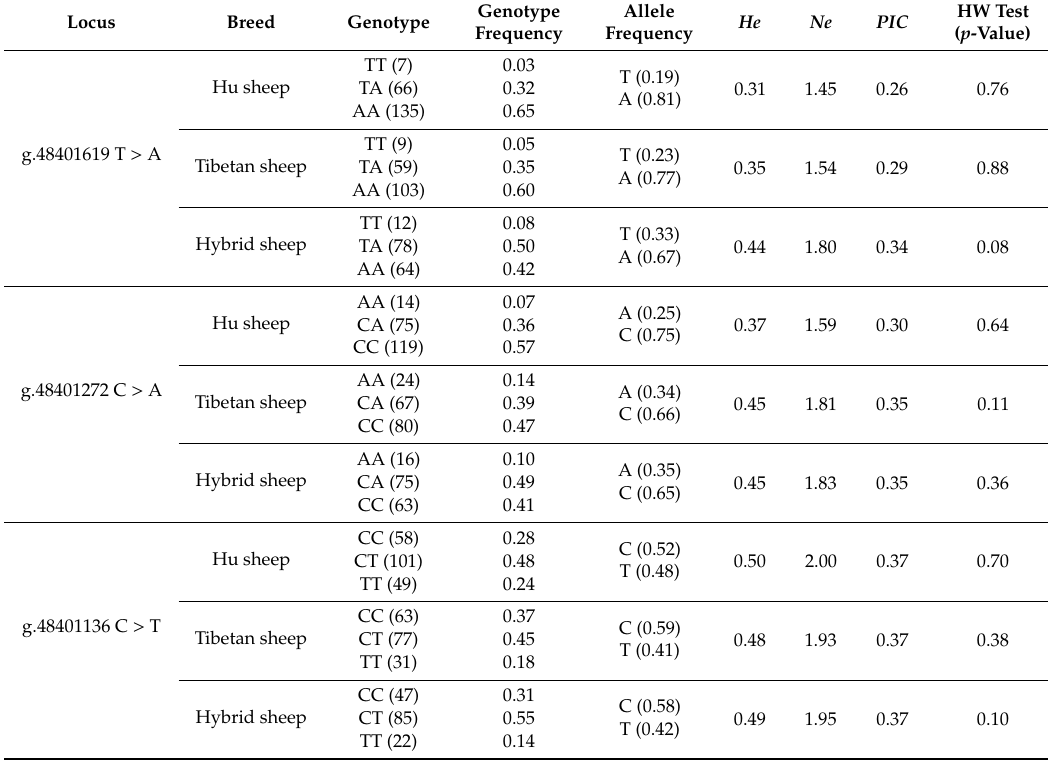
Table 1. Diversity parameters for the sheep BMP2 gene.